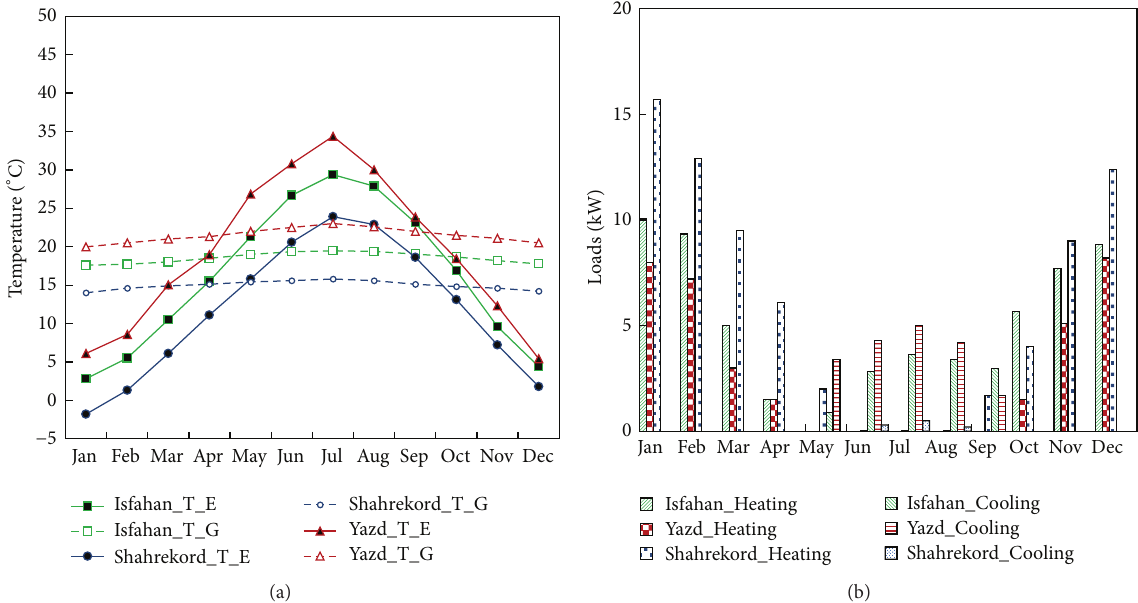
Figure 2: Monthly variations of environment and ground temperature for different cities (a) and corresponding cooling and heating loads calculated with available software